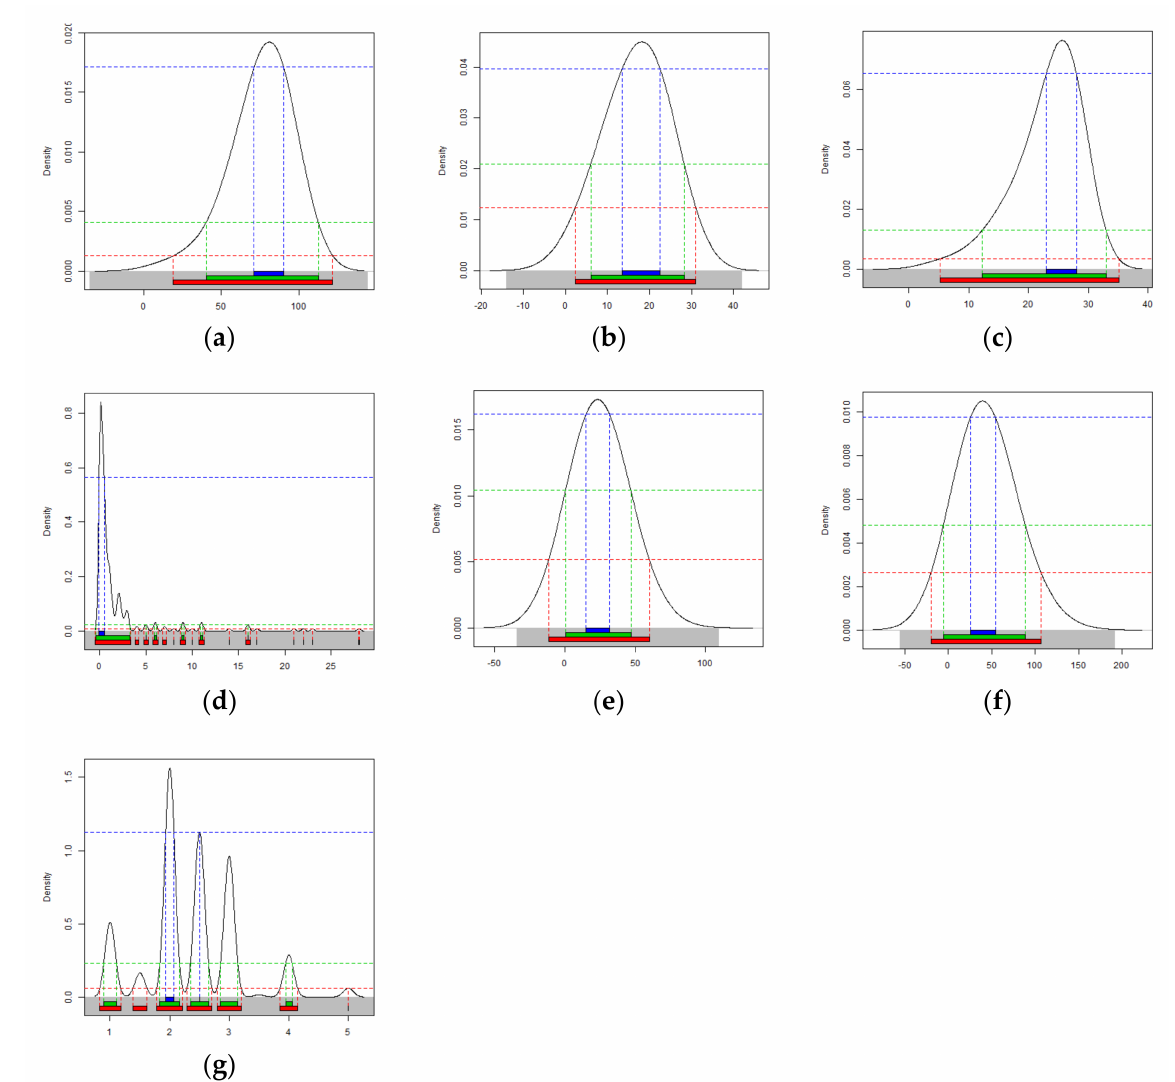
Figure 1. Density plots showing the distribution of the subjects’ neuropsychological test results: ( a ) Schwab and England activities of daily living (ADL) score, ( b ) Korean montreal cognitive assessment (K-MoCA) score, ( c ) Korean mini-mental state examination (K-MMSE) score, ( d ) Korean instrumental activities of daily living (K-IADL) score, ( e ) Unified Parkinson’s disease rating scale (UPDRS) (motor score), ( f ) UPDRS (total score), and ( g ) Hoehn and Yahr (H &Y) stage. The kernel density curve has a probability of 1 if all are added and the curves have been smoothed. The x -axis is the score for each test. Dark blue color = 50% highest density interval (HDI); green color = 95% HDI; red color = 99%